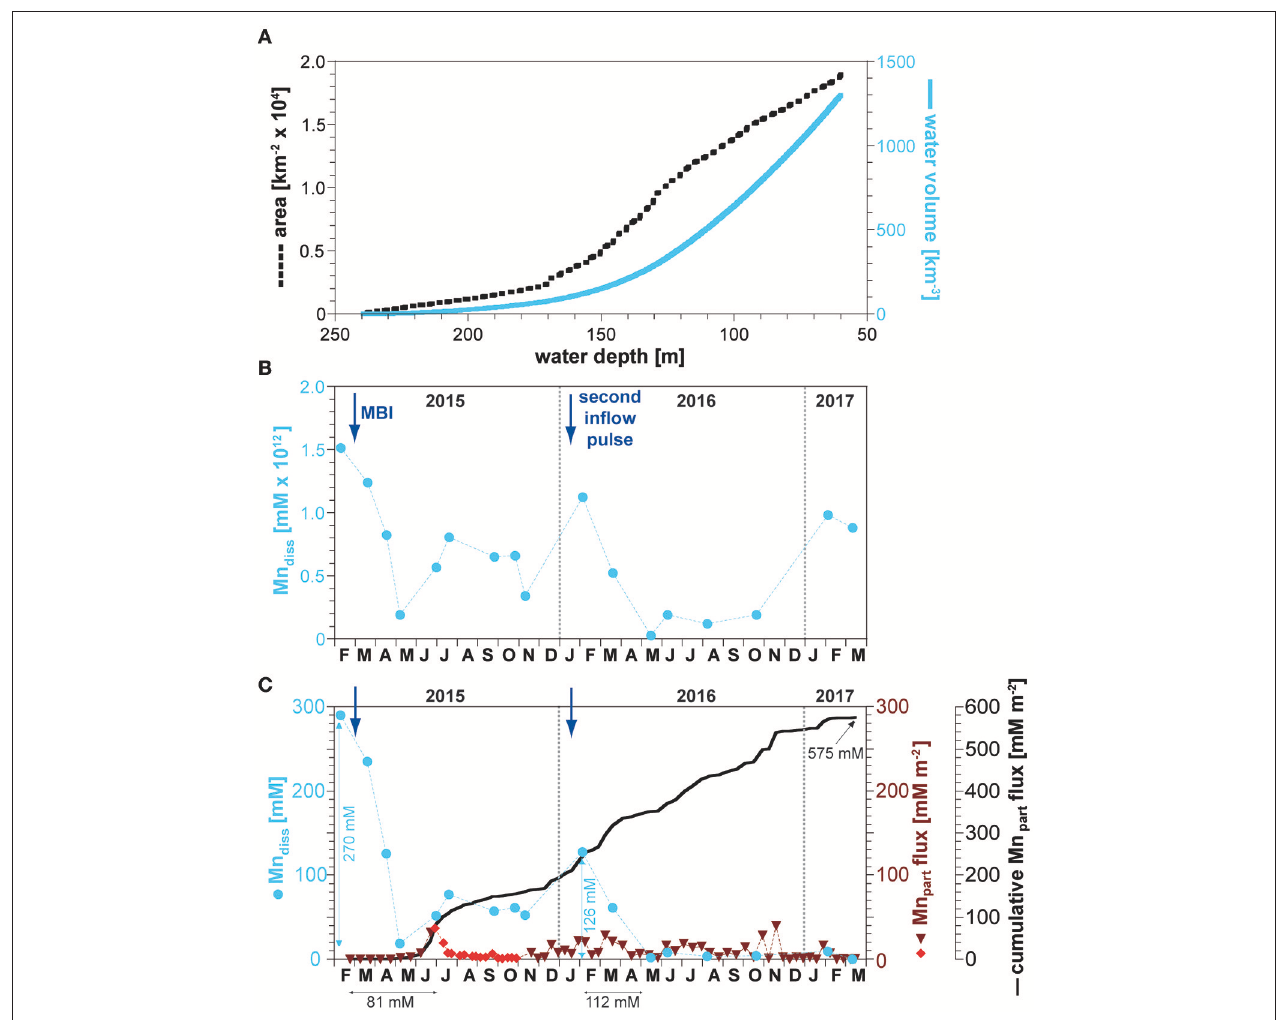
FIGURE 8 | (A) Hypsography of the Gotland Basin (Seifert and Kayser, 1995). Temporal variability of (B) the calculated Mn diss inventories in the water column for the entire basin below a water depth of 70m during the observation period from February 2015 until March 2017 and (C) comparison of Mn diss inventories (blue dots) of the water body above the sediment trap (70–186m water depth, base area 1 m 2 ), sum of Mn part fluxes from the sediment trap for the individual sampling intervals (brown triangles: 2015–2017 red squares: 2003), and cumulative Mn part flux from the sediment trap (black line, total Mn part flux = 575mM m − 2